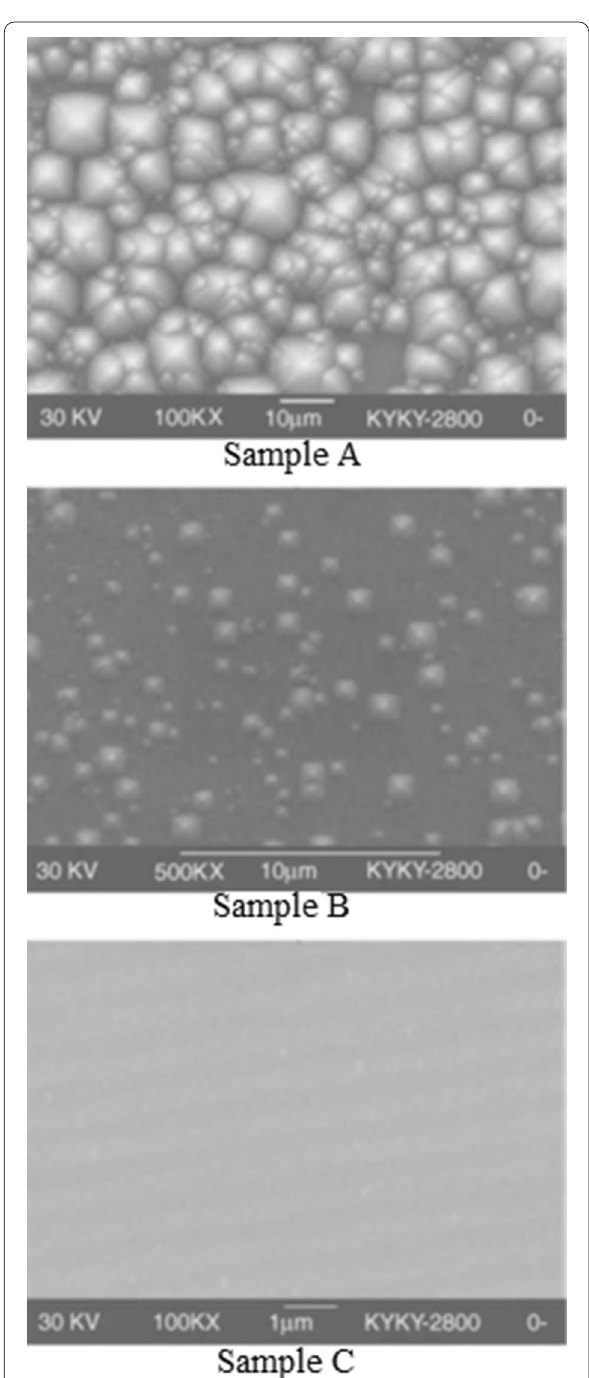
Fig. 10 SEM images of Si{100} surface etched in 5 wt% TMAH under three different agitation conditions: a Sample A: without agitation, b Sample B: with rotational stirrer agitation, and c Sample C: with ultrasonic agitation of 300 W [66], © 2002,